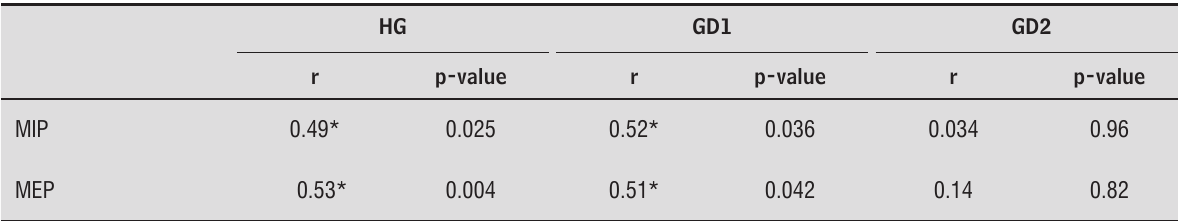
Table 4 - Correlations between maximal respiratory pressures and